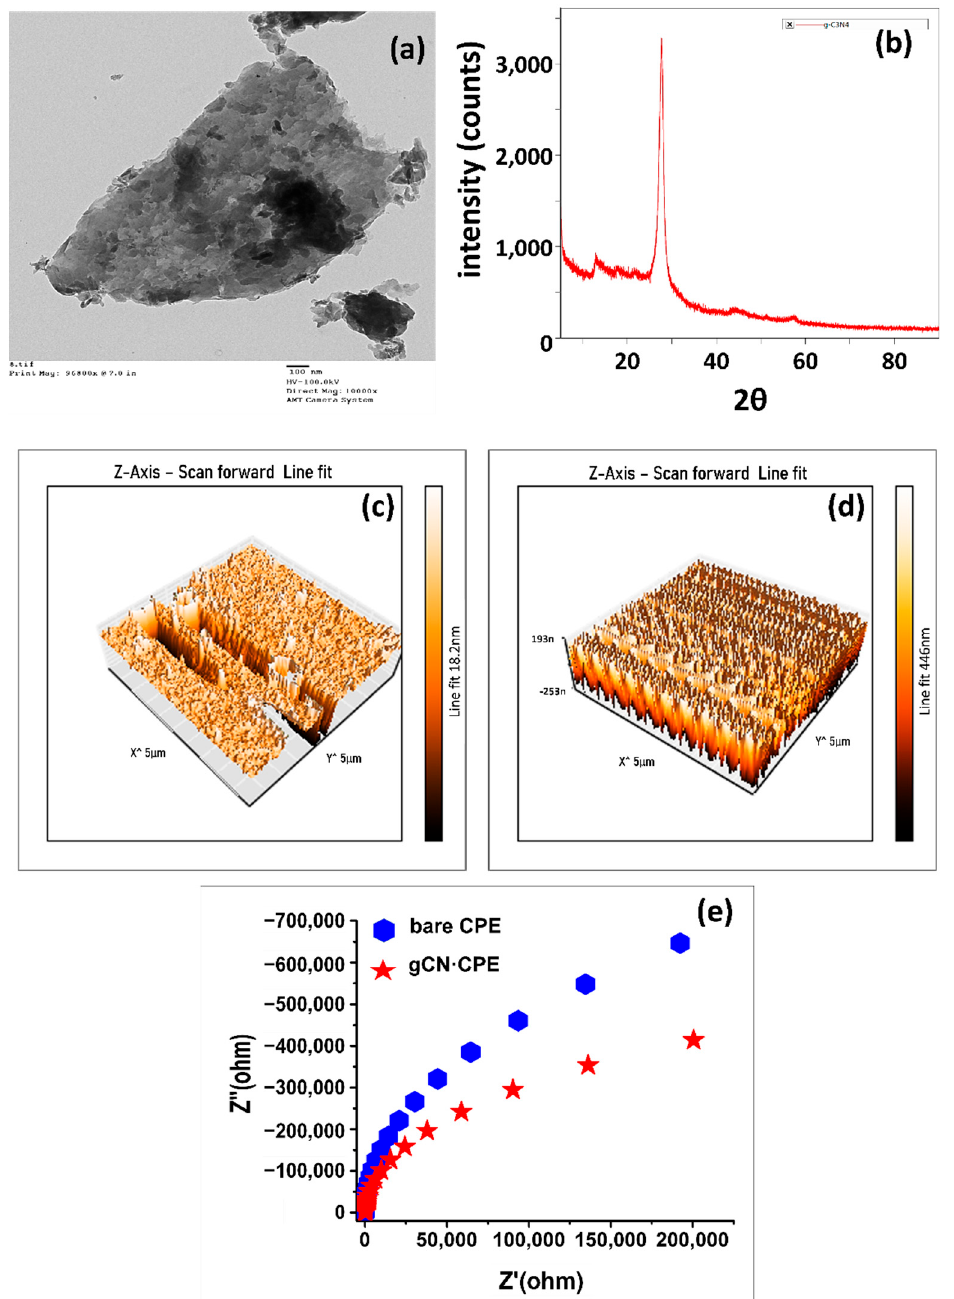
Figure 3. Characterization of electrode material-gCN: ( a ) TEM image, ( b ) XRD image, AFM images of ( c ) CPE, and ( d ) gCN · CPE and EIS study of developed electrodes. ( e ) Nyquist plot.